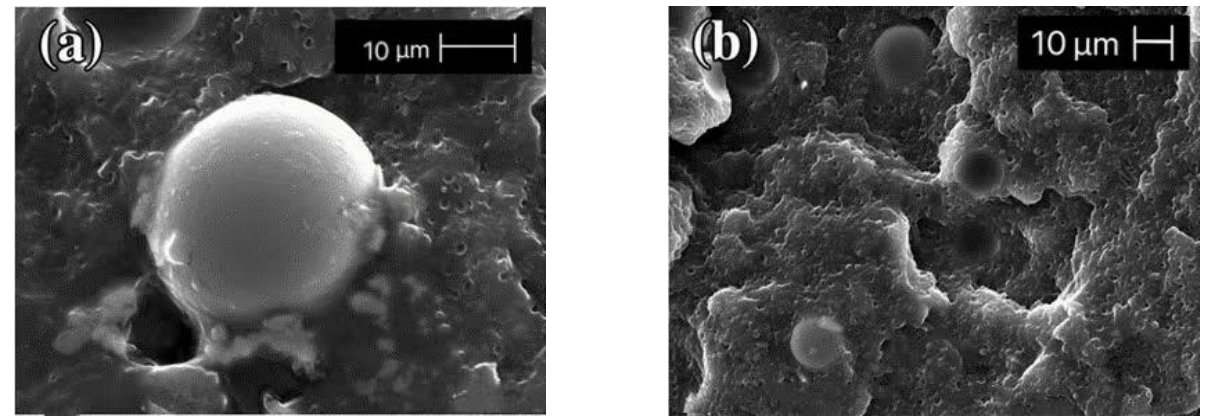
Figure 13. Interface diagram and partially enlarged figure of a composite with a coupling agent. ( a ) Mag = 1900×; ( b ) Mag = 1000×. Adapted with permission [63], Copyright 2016, Springer.